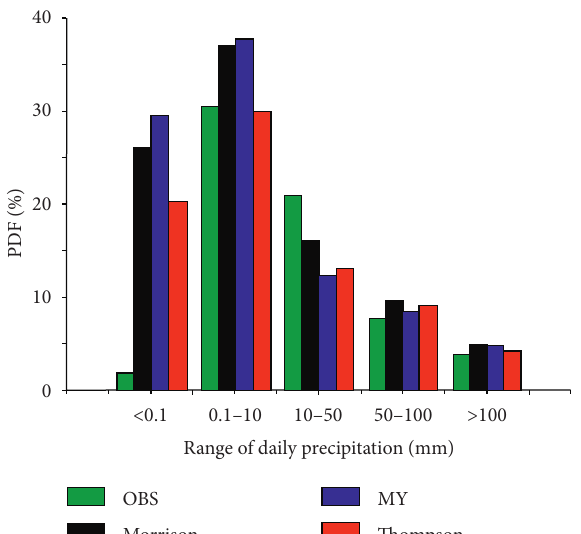
Figure 5: PDFs of the cumulative precipitation in 24 hours between the observations and WRF simulations using the three microphysics schemes (Morrison, Thompson, and MY).